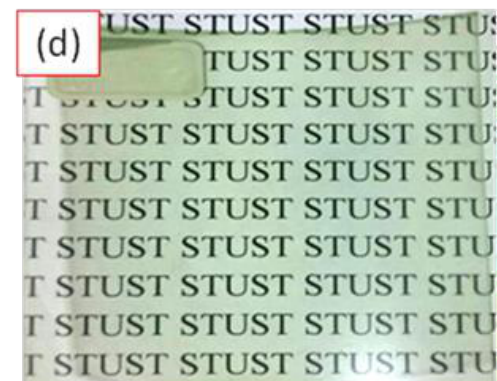
Figure 7. Photograph of ( a ) the PET sheet; ( b ) UV coating; and ( c ) UV coating / 5 wt% PANDB conductive composite film; and ( d ) UV coating / 10 wt% PANDB conductive composite film deposited on PET sheets. The abbreviation of the school (STUST) was placed behind the PET sheet.